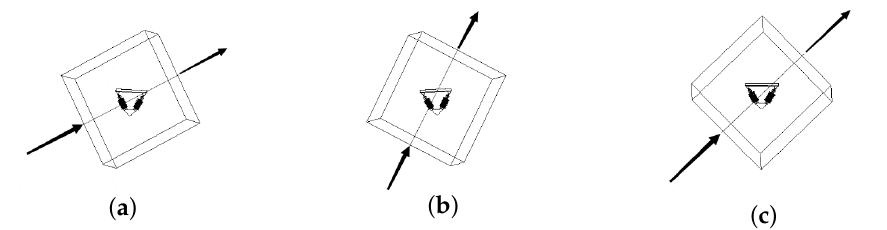
Figure 8. Schematic diagrams under different wind elevation angles. ( a ) 30 ◦ wind elevation angle; ( b ) 45 ◦ wind elevation angle; ( c ) 60 ◦ wind elevation